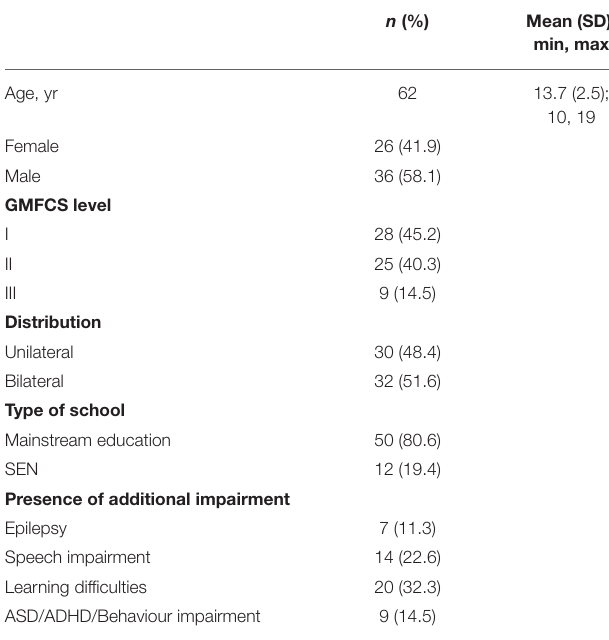
TABLE 1 | Participant